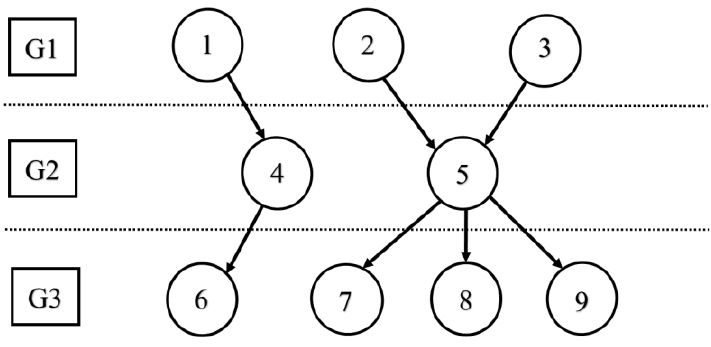
Figure 4. Task Decomposer.